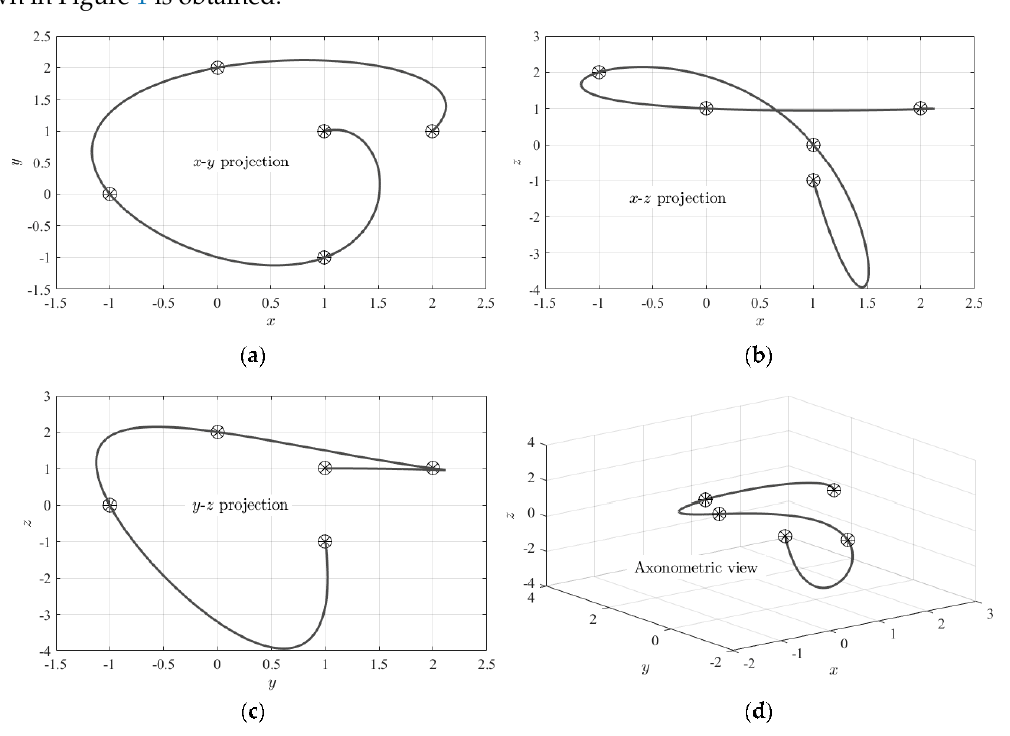
Figure 1. Different views of the nonlinear interpolating trajectory obtained using the data given in Table 1. ( a ): x - y projection, ( b ): x - z projection, ( c ): y - z projection, and ( d ): axonometric view Table 1. Selected points’